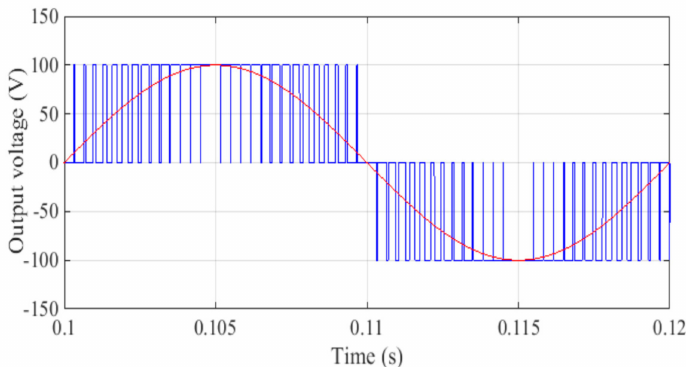
Figure 2. Ideal pulse-width modulation (PWM) inverter output voltage (instantaneous component, blue trace) and its averaged counterpart (fundamental component, red trace) in case of V dc = 100 V and m =